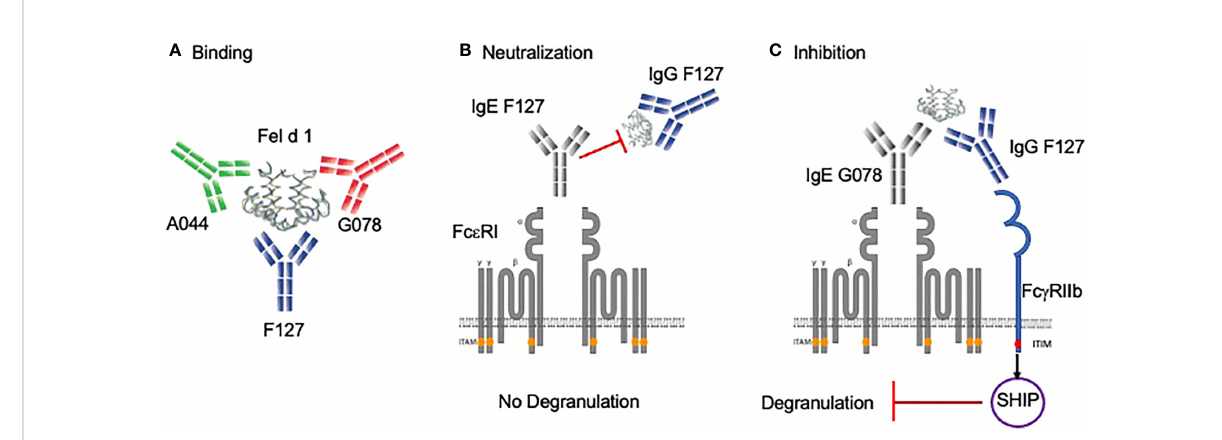
FIGURE 1 Binding and protective role of allergen-speci fi c IgG antibodies in basophil degranulation. (A) Mice were immunized with the vaccine Fel d 1 coupled to Q b -VLP. By mammalian cell display, three monoclonal antibodies (G078, A044, F127) were cloned in IgG and IgE formats that recognize non-overlapping B cell epitopes. (B) Anti-Fel d 1 IgG antibody (e.g. F127) having the same epitope speci fi city as anti-Fel d 1 IgE (e.g. F127) neutralizes Fel d 1. (C) Anti-Fel d 1 IgG antibody (e.g. F127) having a different speci fi city as anti-Fel d 1 IgE (e.g. G078) inhibit degranulation via Fc g RIIb. Created with